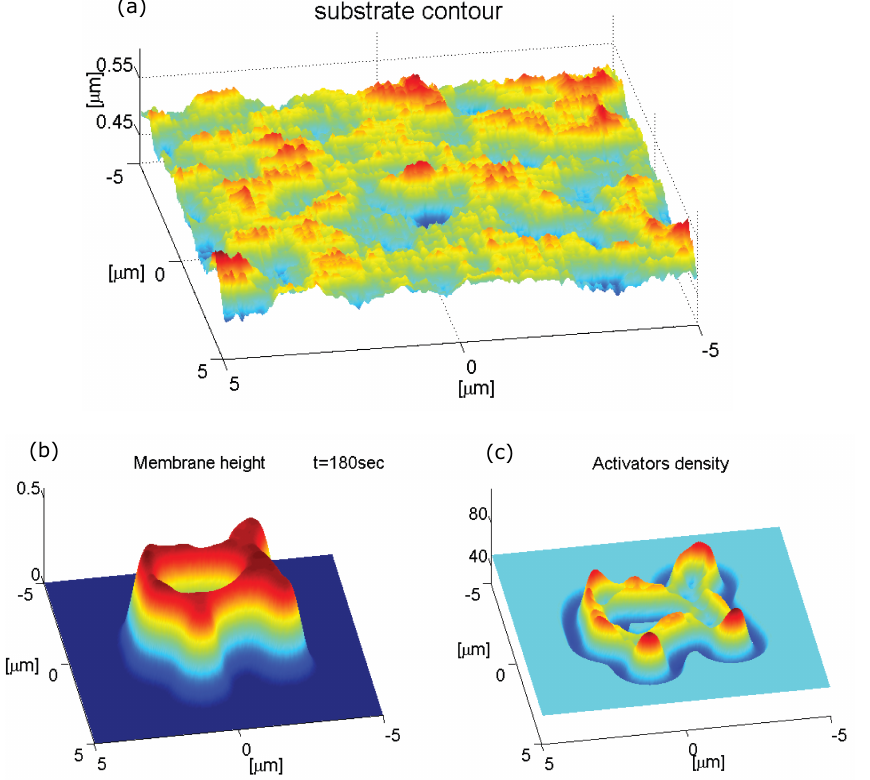
Figure 3. ( a ) Substrate with random roughness, of Gaussian amplitude, with an average amplitude of a few tens of nanometers. ( b , c ) Numerical integration over a period of 3 min of a ring expanding over a membrane segment of size 10 × 10 µ m 2 . We used the same parameter values as in Figure